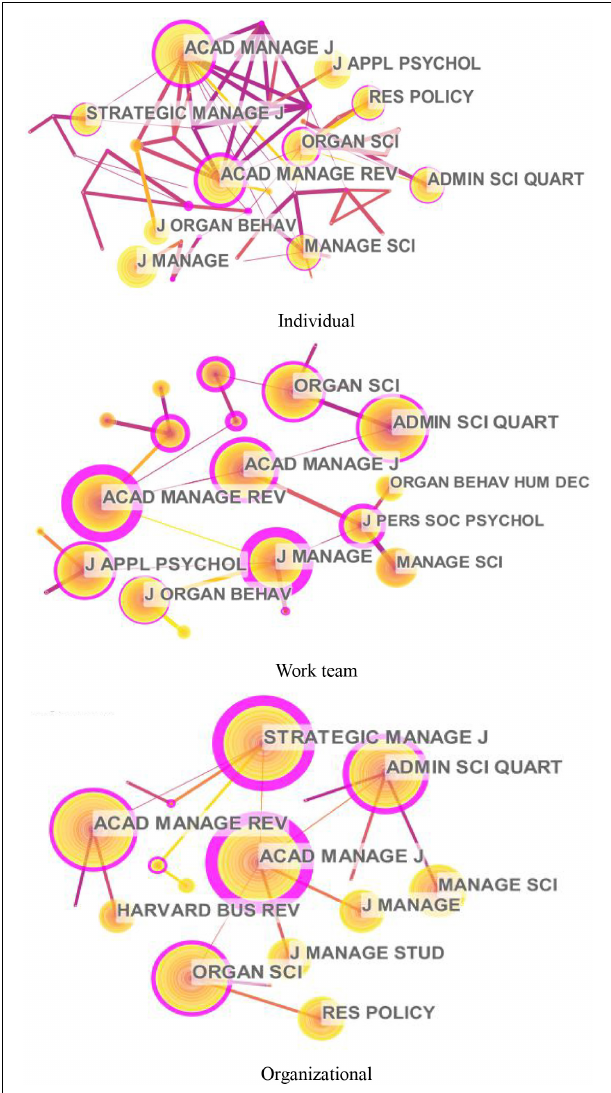
TABLE 3 | Top 10 highly cited journals of innovation research at different